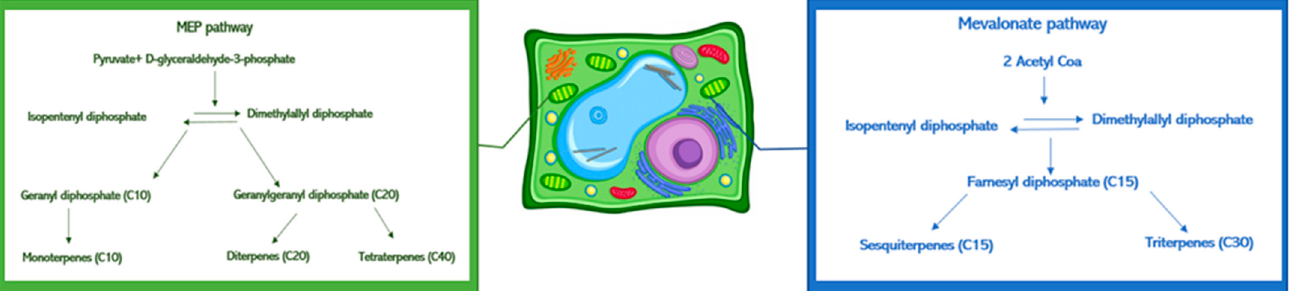
Figure 3. Schematic representation of terpenes biosynthetic pathways in the plant cell. Elevated levels of nonanal observed in treated plants indicate that biostimulants might modulate the lipid-signaling pathways controlling the enzyme lipoxygenase